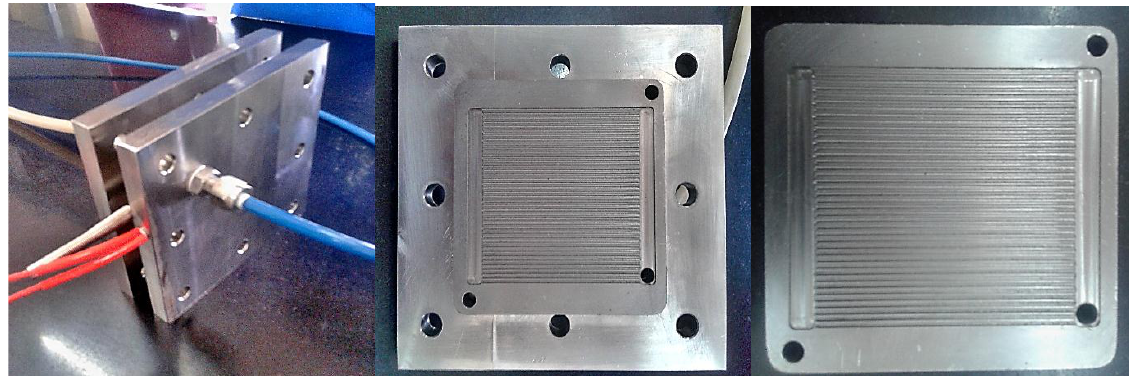
Fig. 2. Micro-channel reactor with jaw plates, connections, heater and